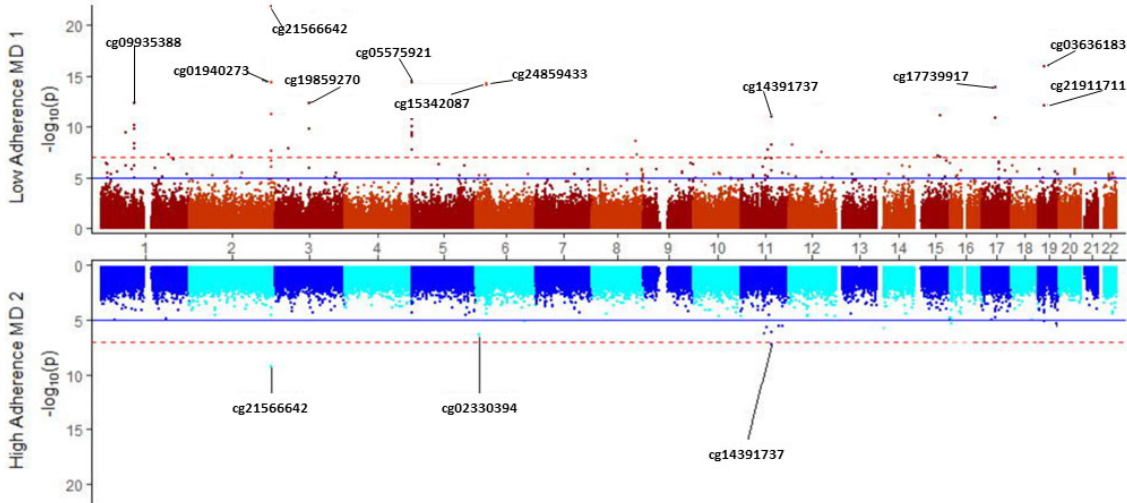
Figure 7. Miami plot for the epigenome-wide methylation analysis for smoking (5 levels), depending on the adherence to the Mediterranean diet: Low adherence (above x-axis) and High adherence (below x-axis). The top 11 most significant CpGs for the low-adherence level are highlighted. For the High adherence level, the 3 most significant CpGs are highlighted. Red line represents the EWAS significance level p = 9 × 10 − 8 . The blue line represents p = 1 × 10 − 5 . The GRCh37/hg19 assembly has been used.